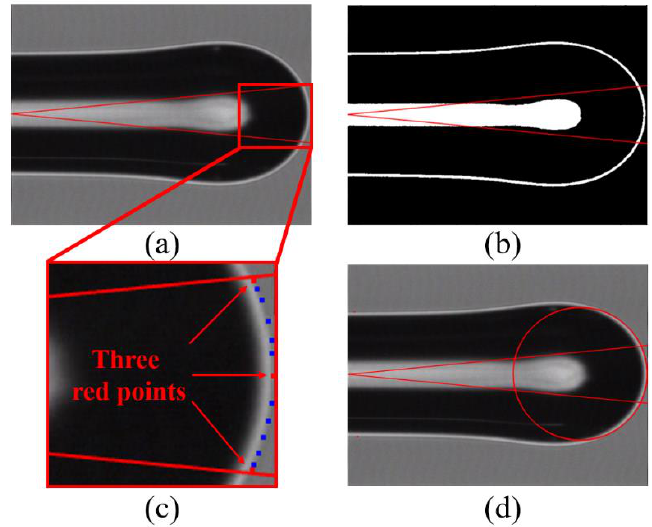
Figure 4. The radius of curvature measurement for a LOF lens surface. ( a ) Microscope image of a fabricated LOF, ( b ) binary image, ( c ) magnified image, and ( d ) curve-fitted image. The red lines represent the area where the beam actually propagates. The red dots in ( c ) were taken from the binary image of ( b ), and used to get the fitting circle of ( d ).